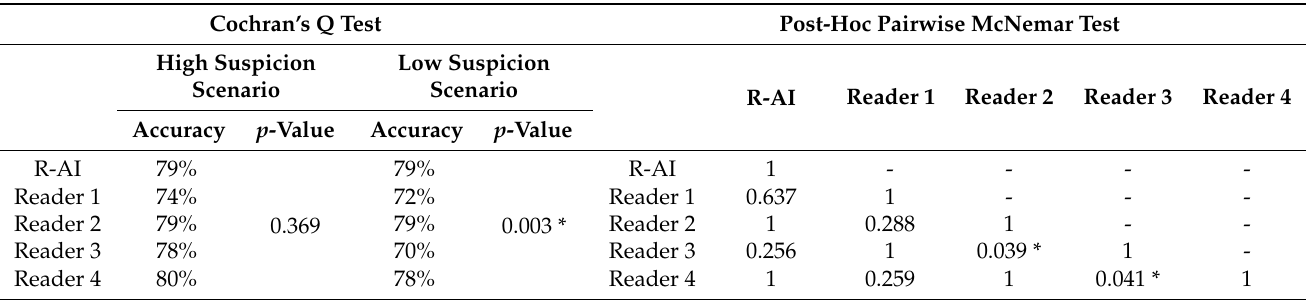
Table 4. Comparative analysis of the diagnostic performance of radiomic-based artificial intelligence classifier (R-AI) and human readers in both high and low suspicion scenarios.